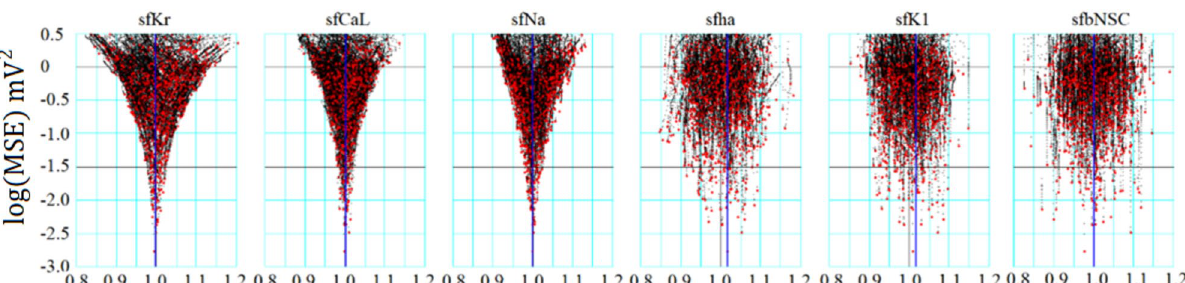
Figure 4. Convergence of sf x in the orp test for Cell86. The ordinate is the log(MSE) and the abscissa is the normalized amplitude of sf x . x denotes Kr , CaL , Na , ha , K1 , and bNSC . Black points were obtained in the progress of optimization, and red points are the final points in 829 runs of PS